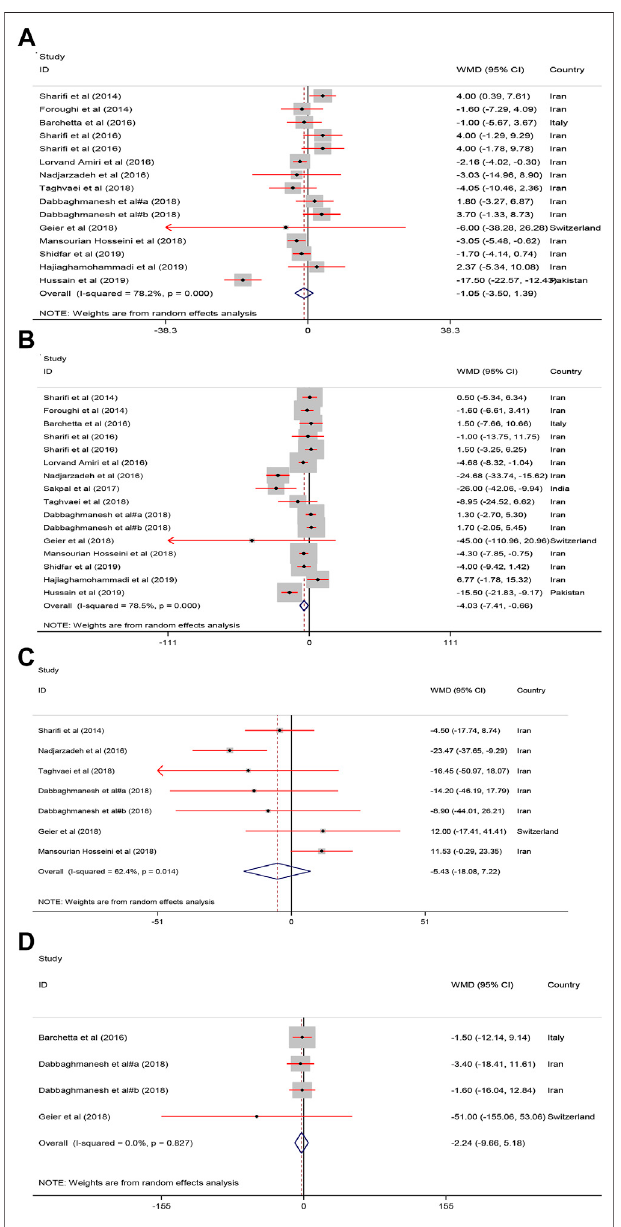
FIGURE 4 | The Liver enzymes standardized mean differences estimates for (A) AST (B) ALT, (C) ALP and (D) GGT between intervention group (receiving vitamin D supplementation) and placebo groups.